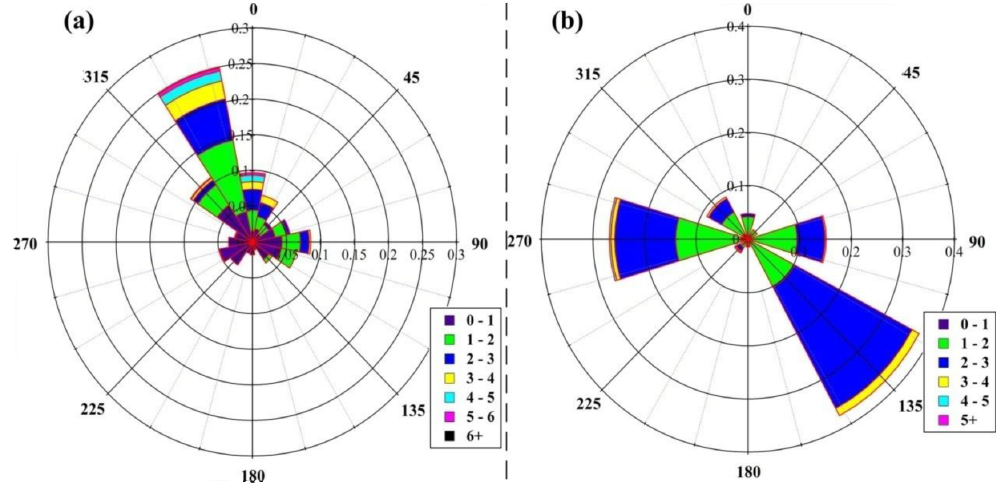
Fig. 5. Combined wind rose maps at daytime hours during the sampling period at (a) TMS and (b) TW.